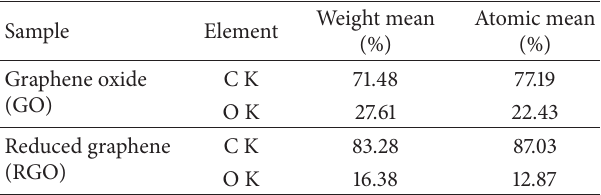
Table 1: Elemental analysis for graphene oxide (GO) and reduced graphene (RGO) of pure